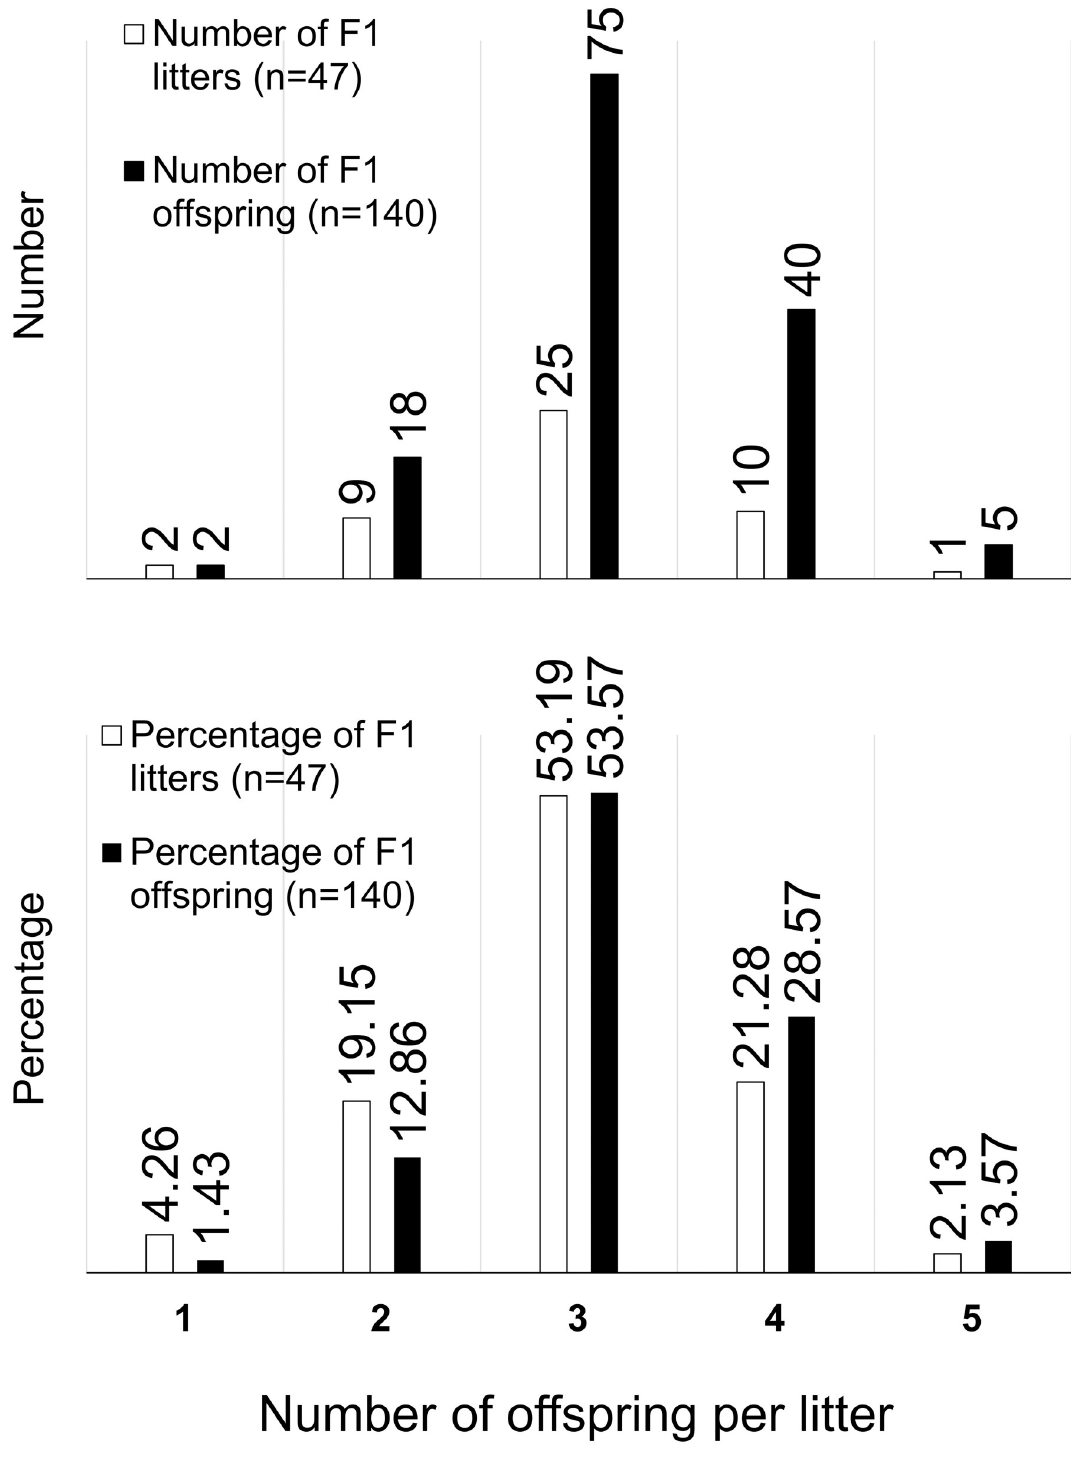
Fig 1. Range of litter sizes in absolute numbers and percentages. Triplet litters are most common, producing the greatest number of offspring overall.